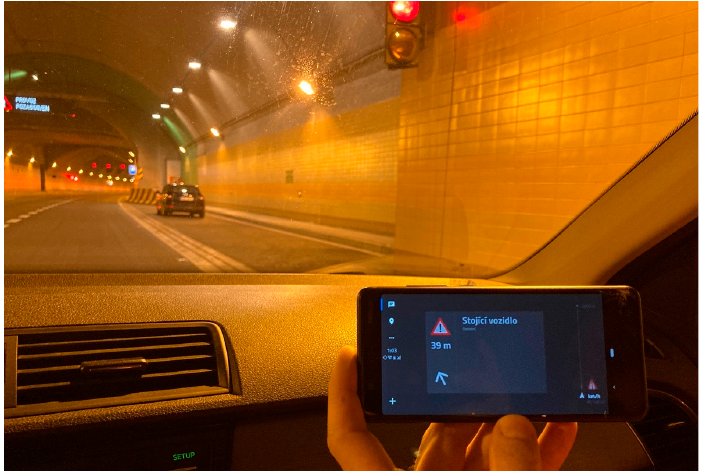
Figure 7. Testing of the V2X scenario (stationary vehicle) in the Blanka tunnel.